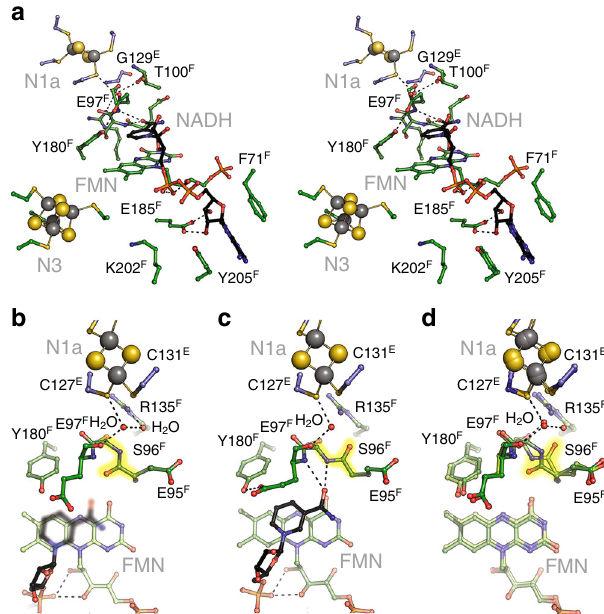
Fig. 2 The structure of the NADH-binding site of complex I. a Enlarged stereo view into the NADH-binding pocket in the reduced state of the protein and bound NADH (carbon in black). b The structure of oxidized NuoEF with bound NAD + , c the structure of reduced NuoEF with bound NADH and ( d ) overlay of the structures of oxidized and reduced NuoEF in the absence of pyrimidine nucleotides. The fl ipping peptide bond is highlighted in yellow and hydrogen-bonding interactions are indicated by dashed lines. The C = O group of the peptide bond between E95 F and S96 F points toward the FMN in the oxidized state of the protein with and without bound NAD + and fl ipped away in the reduced state of the protein with and without NADH